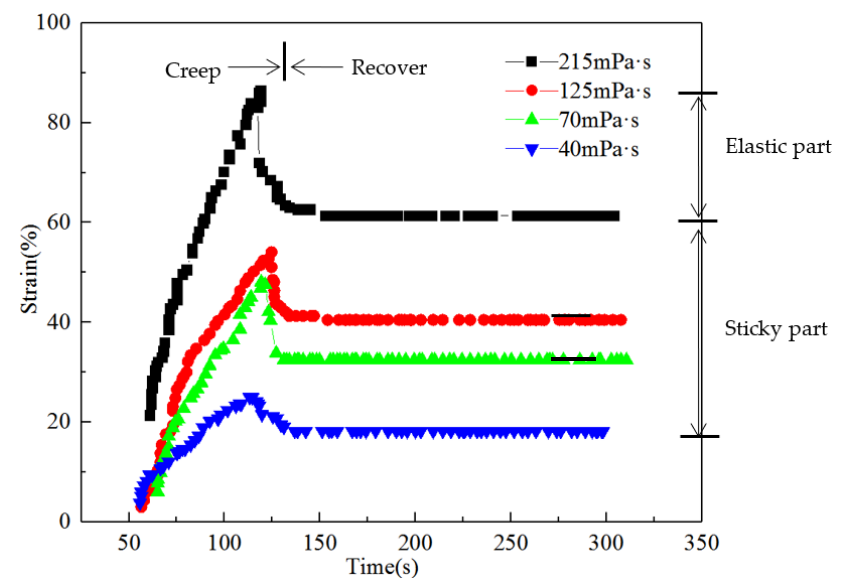
Figure 3. Creep recovery curves of polymer solutions with different viscosities.